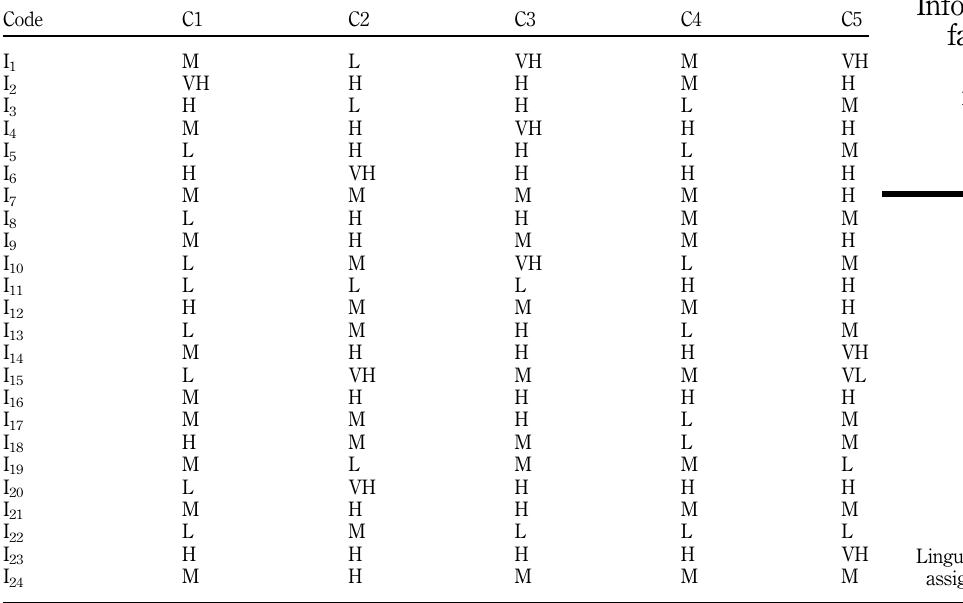
Table A3. Linguistic